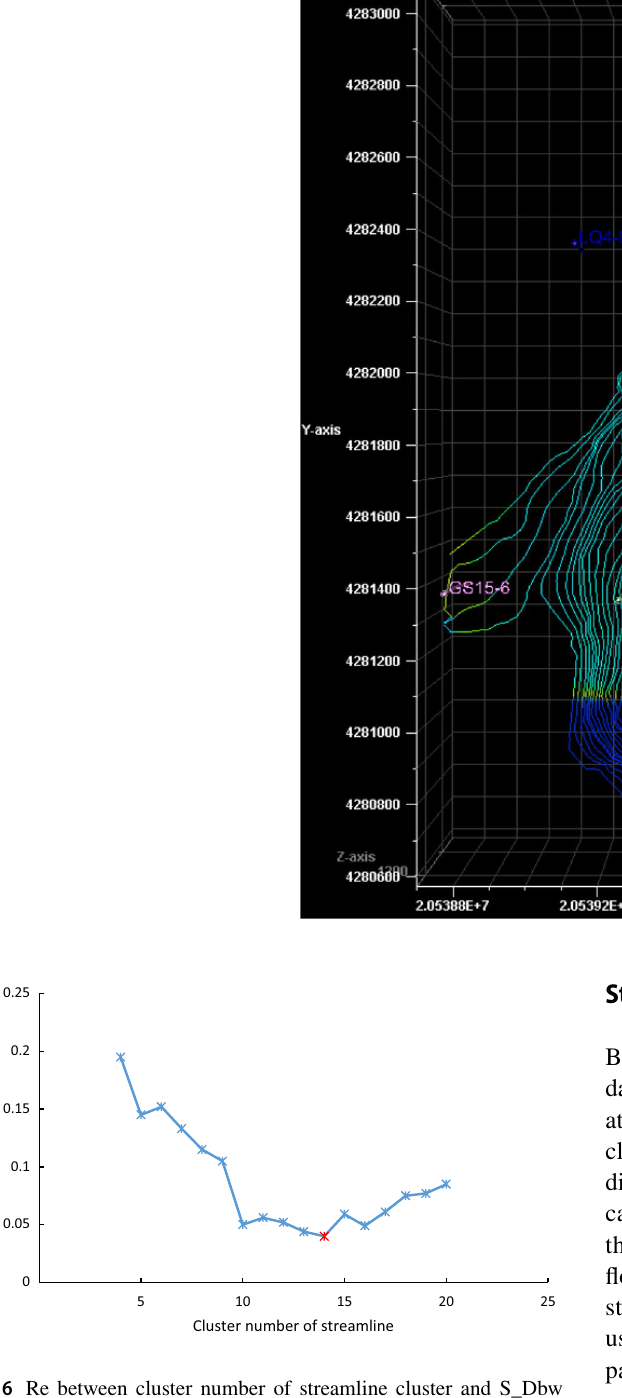
Fig. 5 Streamline distribution of the Nm3-4-1 layer in the Gang Dong oil field